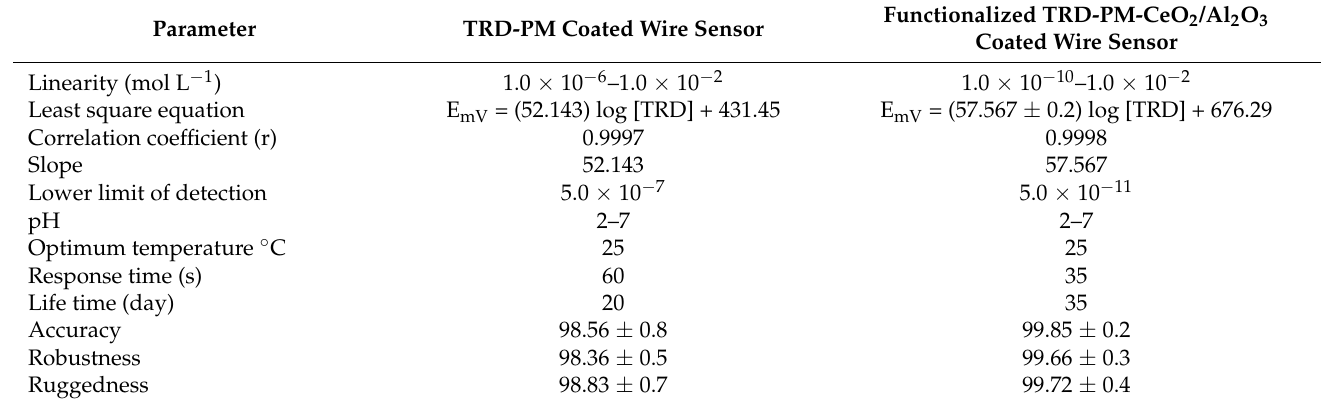
Table 1. Performance response characteristics of designed conventional (TRD-PM) and functionalized TRD-PM-CeO 2 /Al 2 O 3 nanocomposite